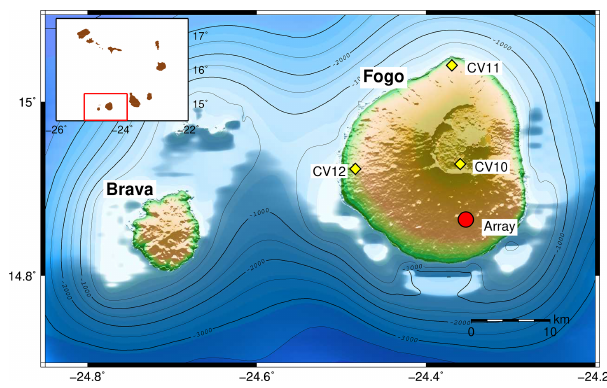
Figure 1. Location of the island and station locations on Fogo. Cir- cle: location of the array, which consists of 10 stations, of which 7 were operational. The array was operated from October 2015 to December 2016. Diamonds: additional single-broadband stations. These were operational from January 2016 to December 2016. In- set top left: map of Cabo Verde, red rectangle: current map section of Brava and Fogo. Topographic and bathymetry data are from Ryan et al.